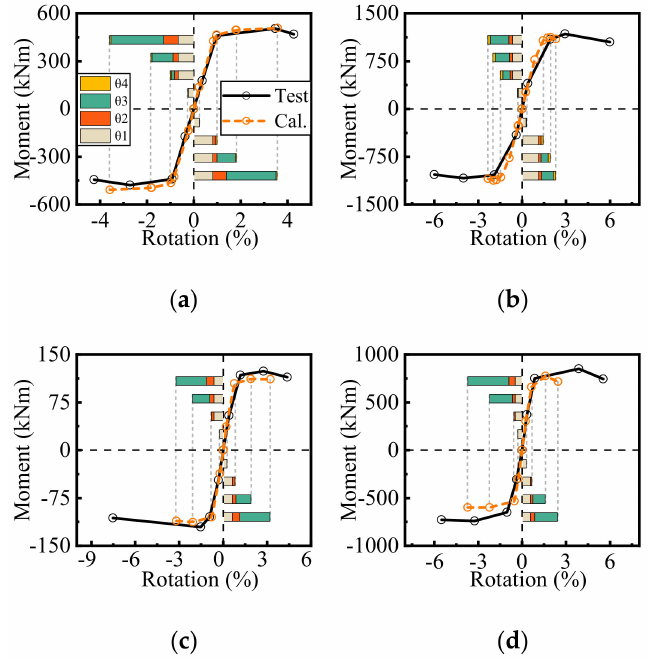
Figure 10. Comparison of prediction and test results of moment–rotation curves. ( a ) S2 adapted from ref. [32]; ( b ) A2 adapted from ref. [27]; ( c ) P-ECC2 adapted from ref. [28]; ( d ) Specimen 3 adapted from ref.